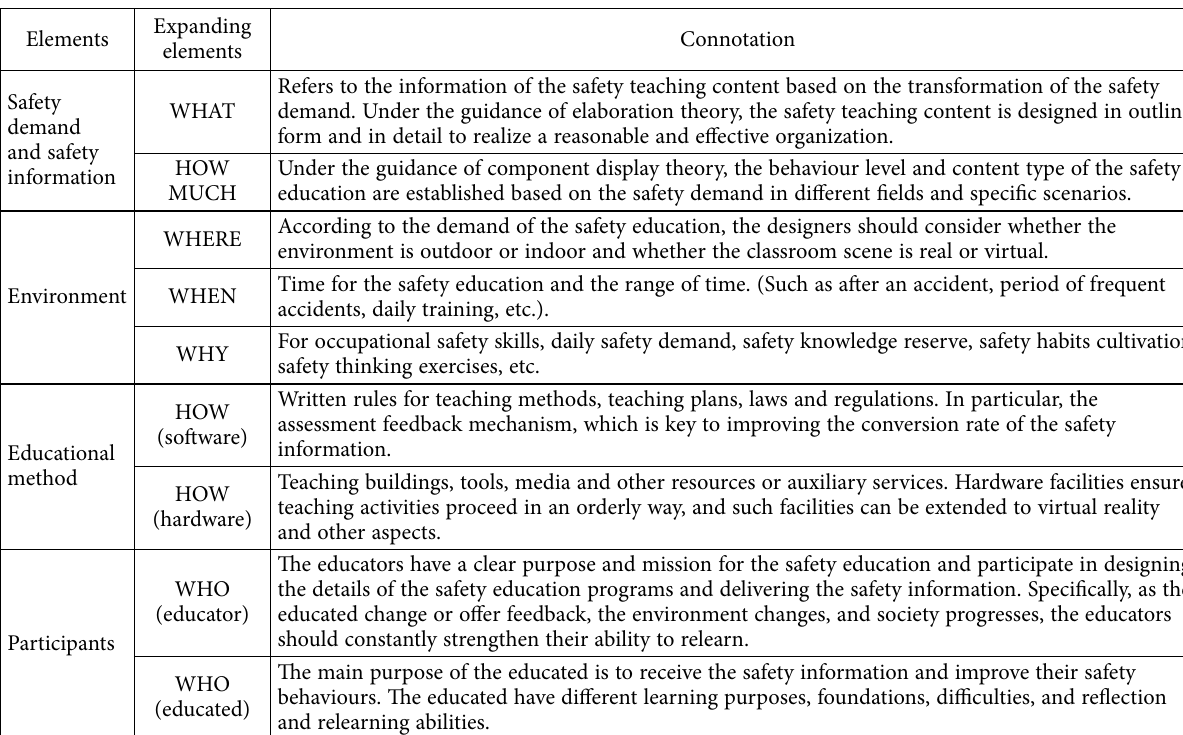
Table 3. Expanding the elements analysis of safety education